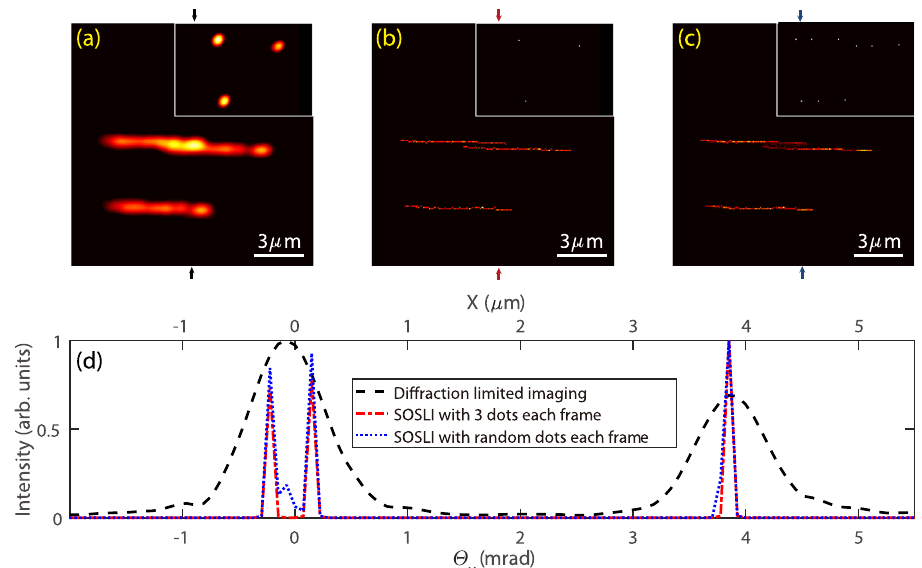
Fig. 6 SOSLI demonstration with sub-wavelength resolution. a Superposing multiple low-resolution images of a three-point sample at various random positions; inset: a typical low-resolution image. b The SOSLI result of a three-point sample at different random places; inset: a typical localization image. c The SOSLI image with randomly appearing points; inset: a typical localization image. d Intensity pro fi le across the vertical line of three images (corresponding to the colored arrows on a , b , c